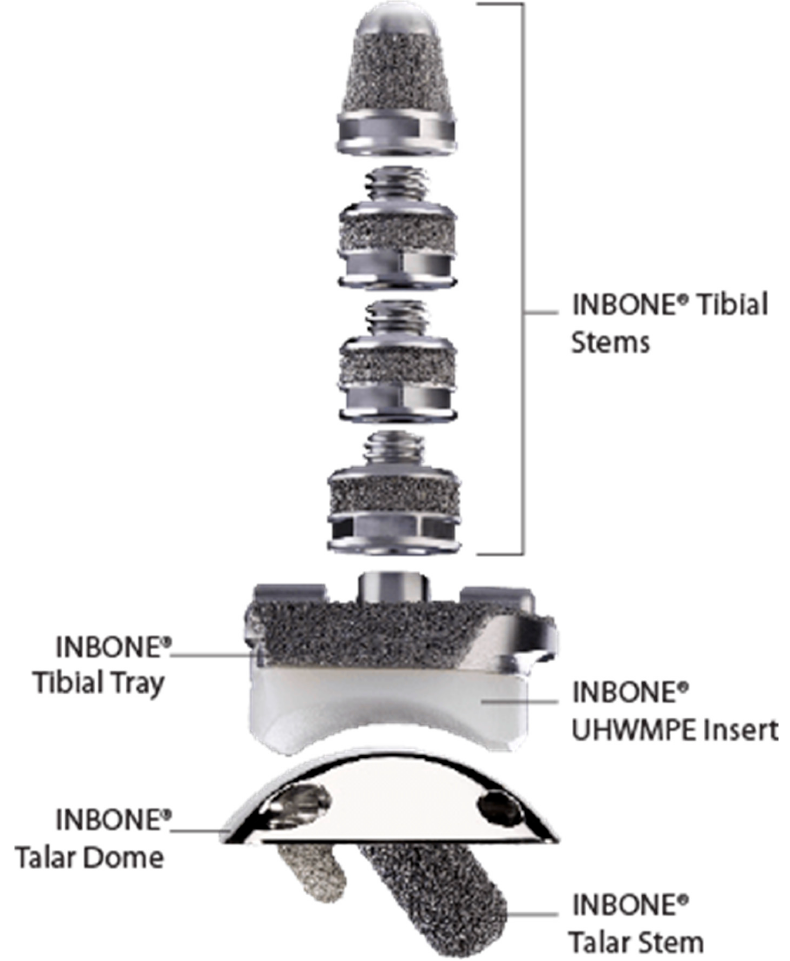
Figure 5. INBONE prostheses and the labeled